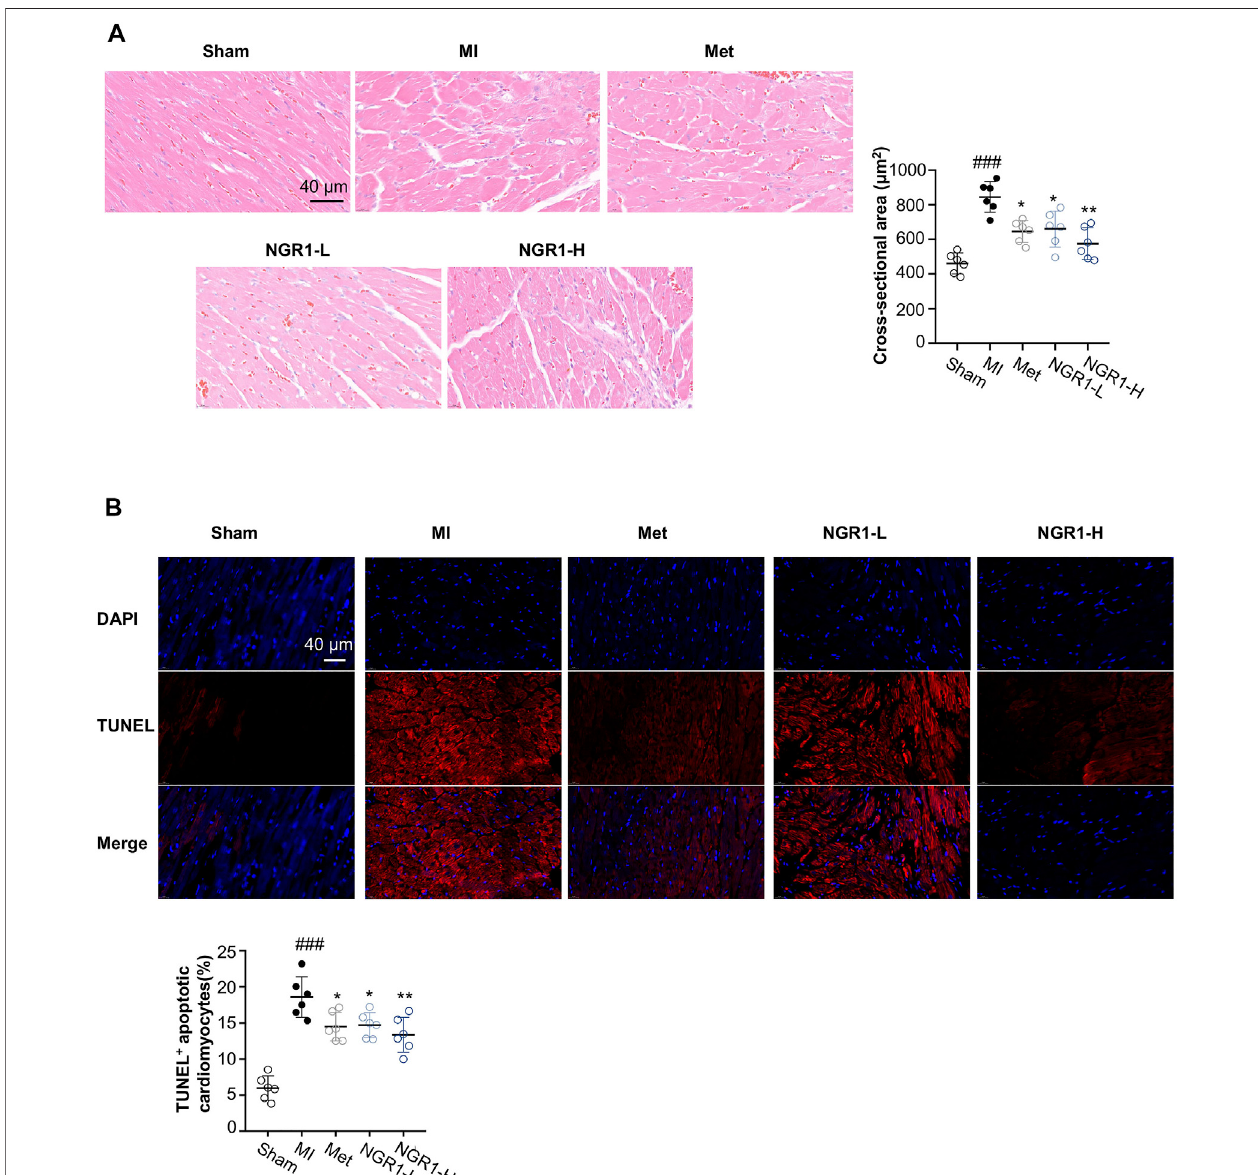
FIGURE2| RepresentativeimagesofhistopathologyandTUNELstaining. (A) Representativephotomicrographsofcardiac tissuesectionswithH&Estainingand quantitativeanalysisofthecross-sectionalarea.Scalebar=40 μ m. (B) TUNELassayofapoptoticcardiomyocytes.Scalebar=40 μ m.Valuesexpressed asthemean± SD.* p < 0.05,** p < 0.01,and*** p < 0.001vs.theMIgroup; # p < 0.05, ## p < 0.01,and #### p < 0.001vs.theshamgroup( n =6forsham,MI,Met,NGR1-L,andNGR1-H